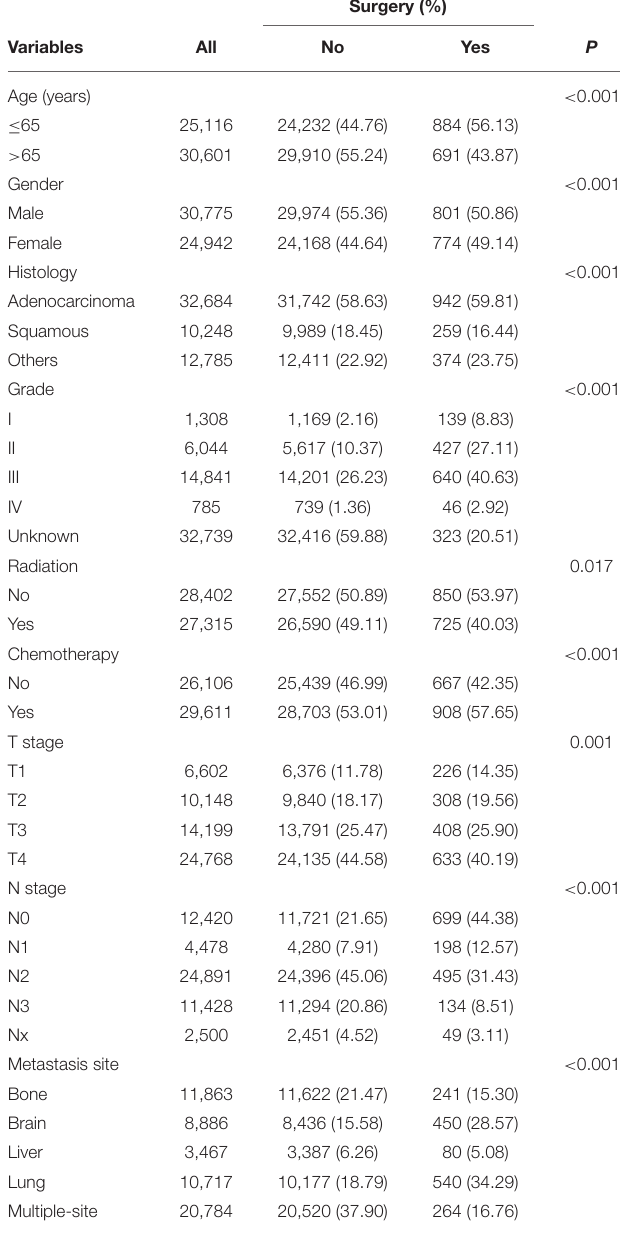
TABLE 1 | Demographics of all patients with primary metastatic lung